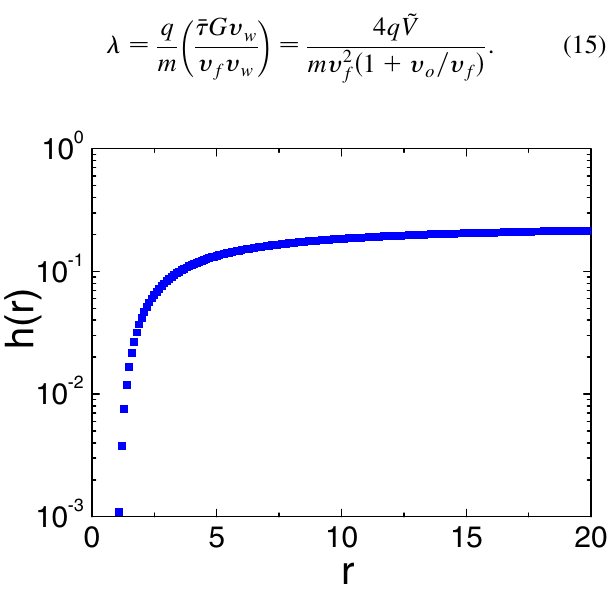
FIG. 2. (Color) Sketch of dimensionless function h (cid:3) r (cid:4) as a function of r